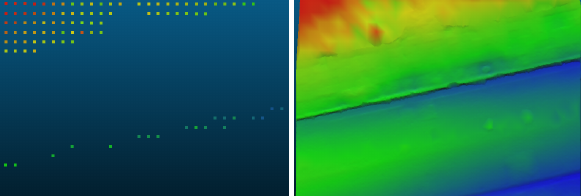
Figure 9. DTM generated from aligned mobile mapping point cloud (Basemap: Google